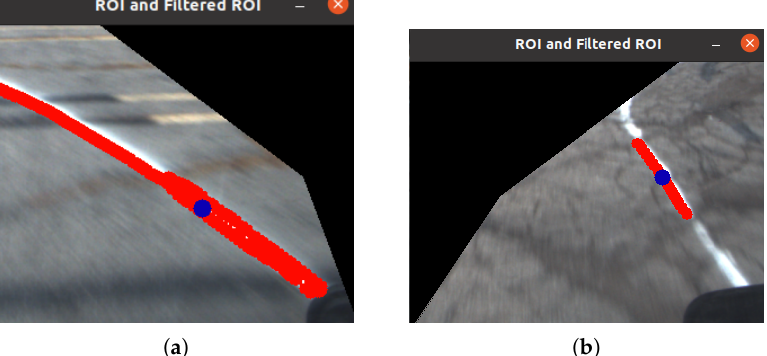
Figure 11. This is a still from the camera of the vehicle when using the blob detection algorithm in the real time environment. As seen in the above figure, the largest white contour is found (marked in red) and the blue dot indicates the centroid of it. The ROI cropping is also seen above. ( a ) Outer lane; ( b ) Inner lane